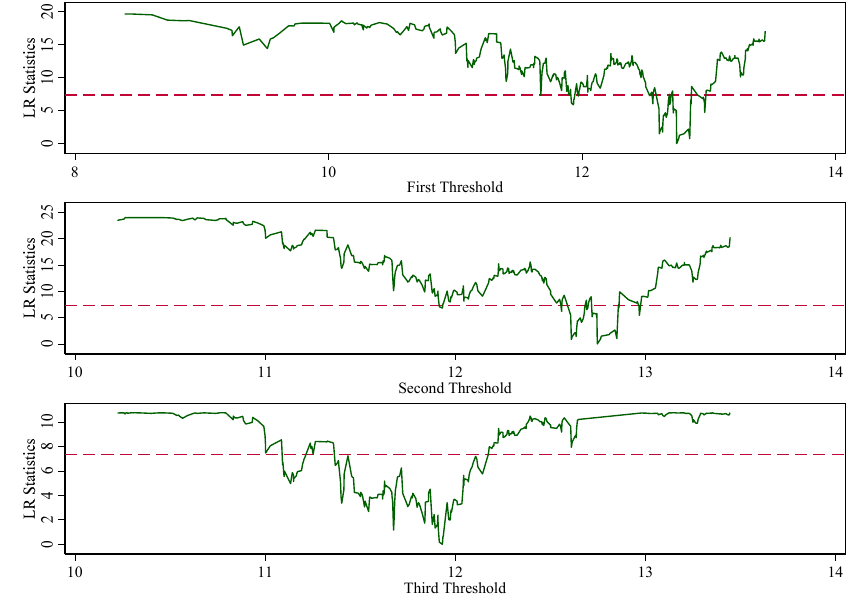
Figure 5. LR test. Note: These graphs were created by the author using Stata 17.0.